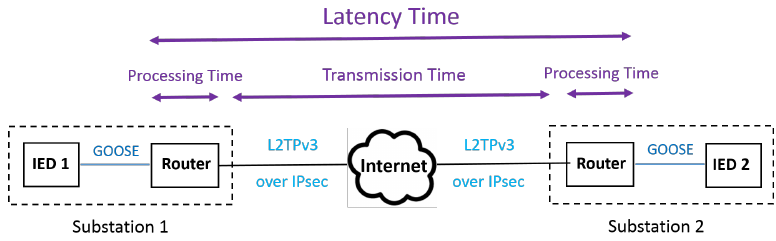
Figure 7. Transmission of secured Generic Object Oriented Substation Events (GOOSE) messages by L2TPv3 over